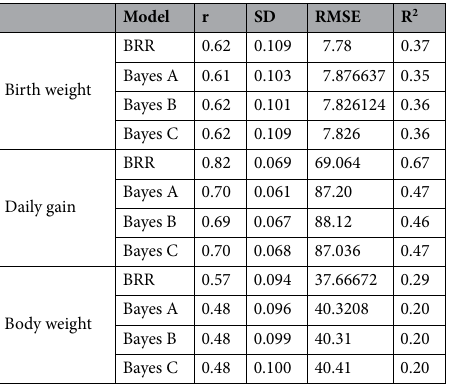
Table 8. The GEBVs accuracy predicted from the 99 SNPs using BGLR package.